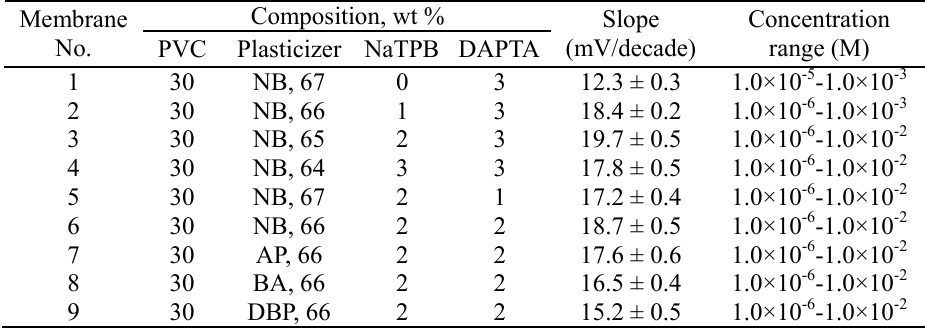
Table 1. Composition of membrane ingredients